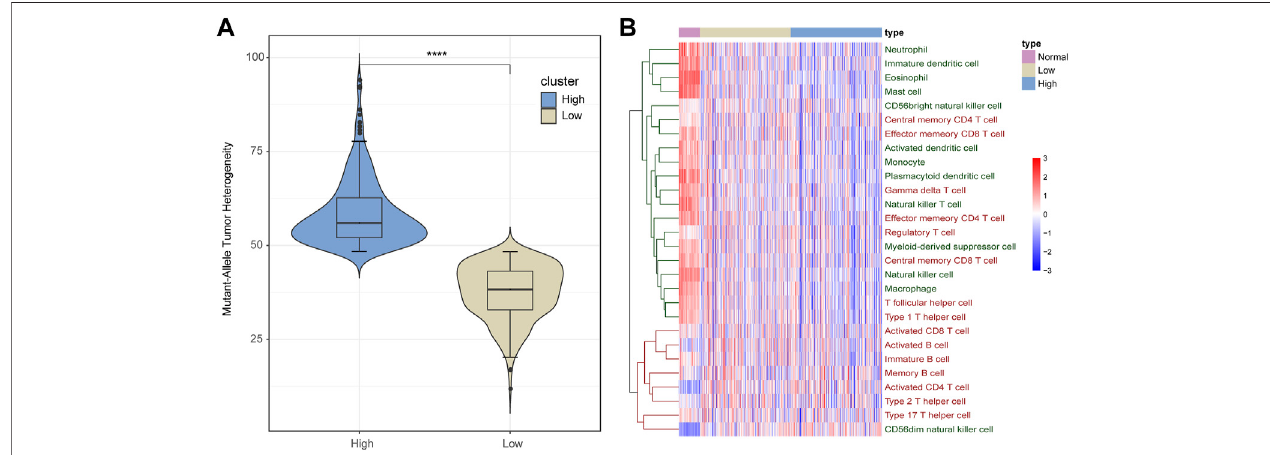
FIGURE1| In fi ltrationofimmunecellsinLUADsamples. (A) AllLUADsamplesaredividedintolow-andhigh-heterogeneousgroupsbasedontheMATHscore. (B) In fi ltration of immune cells varies among normal, low-heterogeneous, and high-heterogeneous cancer. Adaptive immune cells are marked red, and innate immune cells are marked